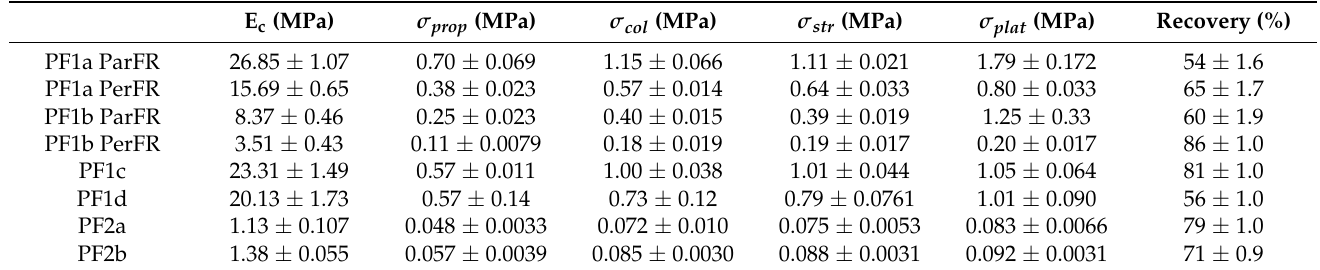
Figure 6. Representative compressive σ c – ε c plots ( a ) PF1 ParFR and ( b ) PF2. Table 3. Compressive properties of PF1 and